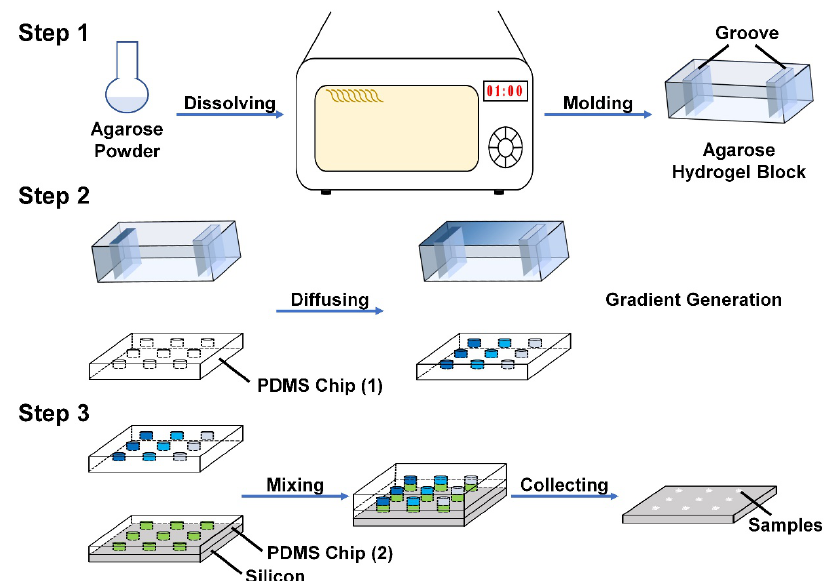
Figure 1. The key steps of performing experiments in the screening platform: Step 1: a hydrogel block with two grooves was fabricated; Step 2: different concentrations of reagent were added into the two grooves respectively, generating a concentration gradient of reagent in the hydrogel block and the half perforated PDMS chip (1) underneath due to diffusion; and Step 3: the reaction was triggered in the microreactors formed by matched arrayed holes in the PDMS chip (1) and fully perforated PDMS chip (2), which was placed on a silicon wafer containing solution with all other required reagents, and precipitated samples of the array were left on the silicon wafer after the reaction.